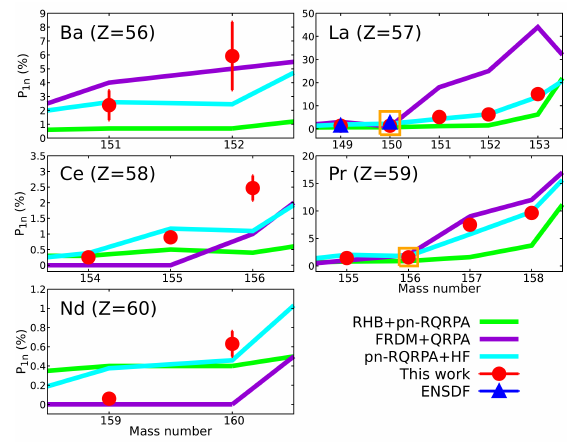
Figure 4. (Color online) Preliminary results for P 1 n from this work (red circles) and previous measurements (blue triangles). These experimental results are compared to the following theoretical models: RHB + pn-RQRPA [13] (green), FRDM + QRPA [4] (purple), and pn-RQRPA + HFM [15] (light-blue). Orange boxes indicate potential isomer contribution